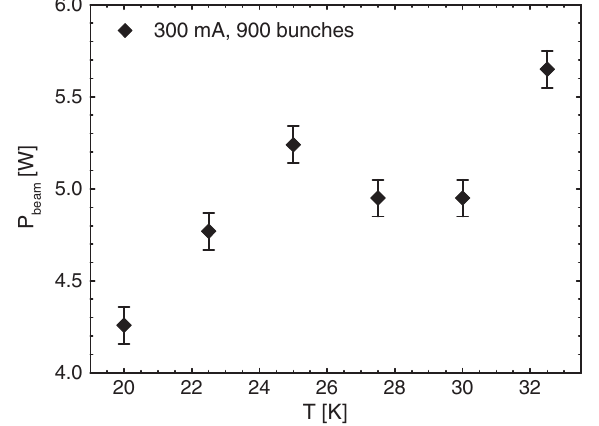
FIG. 5. Beam heat load as a function of the liner temperature at the cooling connection for a fixed filling pattern (300 mA, 900 bunches).